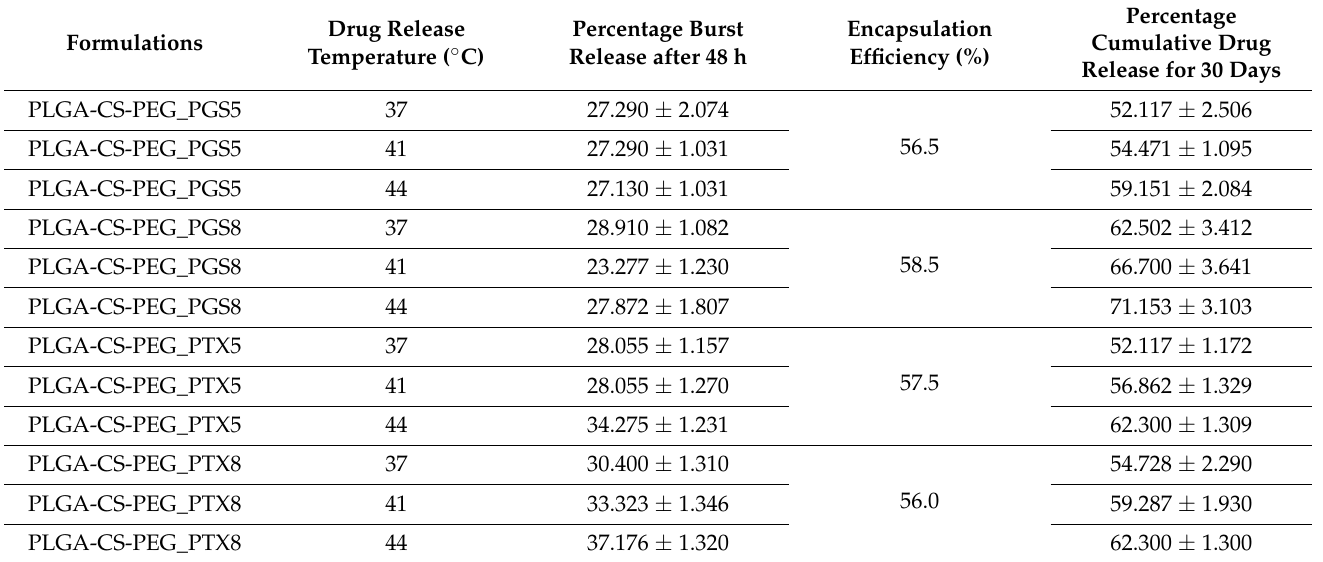
Table 4. The kinetic constant (K), correlation coefficient (R 2 ) and release exponent ( n ) of kinetic data analysis of drug released from drug-loaded PLGA-CS-PEG microsphere formulations.